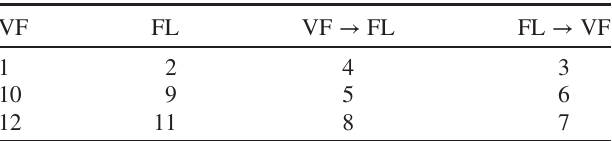
TABLE II. Overview of the items that belong to each repre- sentation or translation between